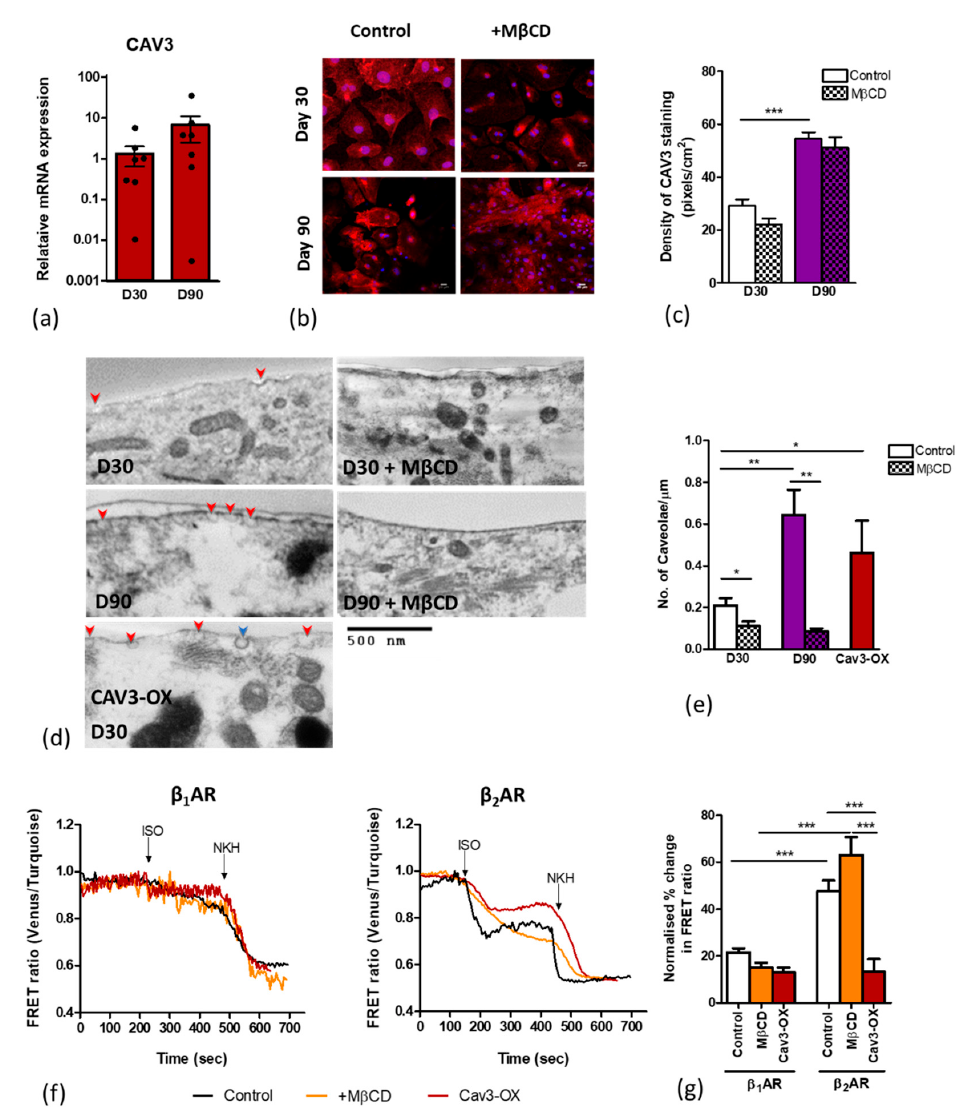
Figure 2. Age-dependent maturation specifically increases the caveolae content. ( a ) CAV3 gene expression in prolonged culture (n/N = 7/3). ( b ) Immunofluorescence staining for caveolin-3 (red) at D30 and D90. Nuclei are stained with DAPI (blue); ( c ) quantification of Cav3 protein density shows a significant increase from D30 (n/N = 19/3) to D90 (n/N = 13/3) *** p < 0.001 between D30 and D90. ( d ) TEM images showing surface caveolae (indicated with red arrows; clathrin pit is indicated with blue arrow) in control ± M β CD treatment, aged iPSC-CMs to D90 ± M β CD, and in Cav3-OX iPSC-CMs; ( e ) quantification of the caveolae density on the cell membrane in D30 control (n/N= 45/2), D30 M β CD-treated (n/N = 37/2), D90 control (n/N = 10/2), D90 M β CD (n/N= 13/2), and Cav3-OX (n/N = 12/1) cells. Data are presented as mean ± SEM. Significance was determined by one-way ANOVA with Bonferroni’s post-hoc test. * p < 0.05, ** p < 0.01; ( f ) representative FRET traces in control (black), M β CD-treated (orange), and Cav3-OX (red) iPSC-CMs (D30) upon either β 1 AR or β 2 AR stimulation with isoprenaline (30µM) in the presence of a specific blocker (CGP (100nM) or ICI (50nM), respectively) and, subsequently, the addition of NKH (10µM) for adenyl cyclase stimulation. ( g ) The percentage change in the FRET ratio upon β 1 AR stimulation in control (n/N = 97/11), +M β CD (n = 62/11), and Cav3-OX (n = 6/2); and β 2 AR stimulation in control (n/N = 38/4), +M β CD (n = 28/3), and Cav3-OX (n/N = 9/2). Percentage change was calculated and normalised to the maximal cAMP released by the NKH477 stimulation. Data are presented as mean ± SEM. Significance was determined by one-way ANOVA with Bonferroni’s post-hoc test. *** p < 0.001. n/N = cells/batches